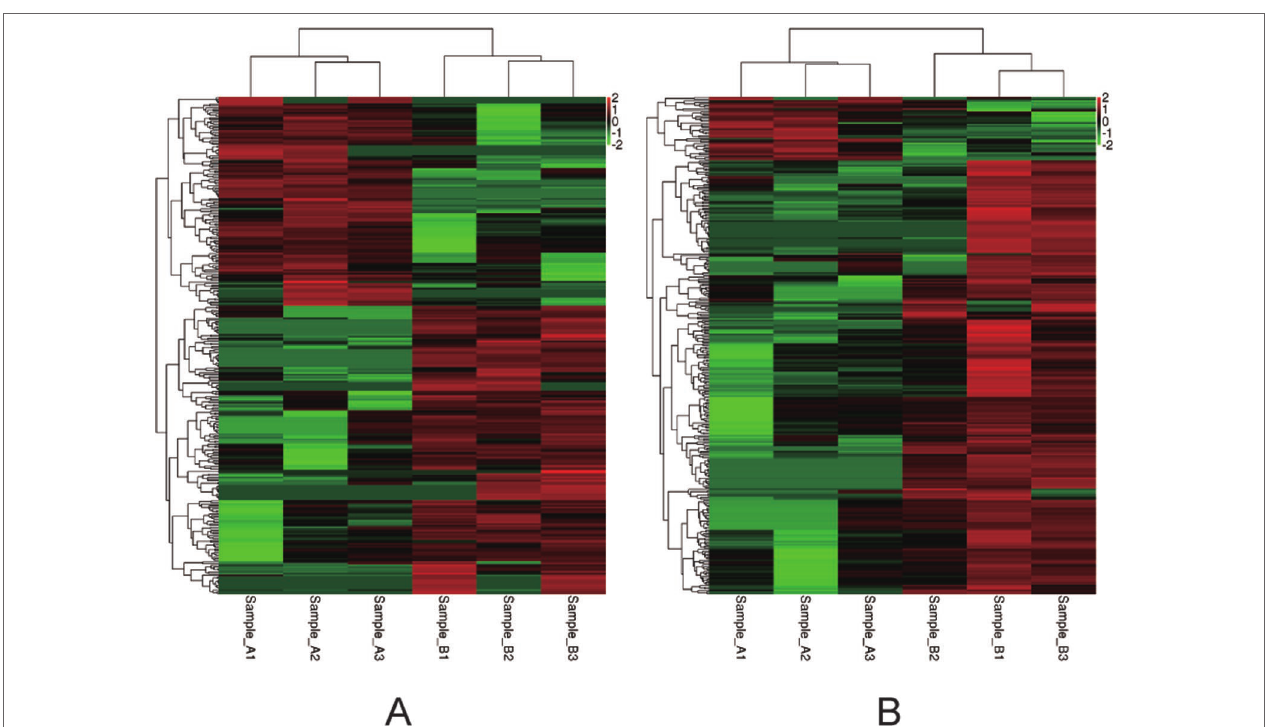
FIGURE 4 | Heat-maps (A and B) of hierarchical clustering analysis depicting the DEGs. The horizontal ordinate represents the clustering of samples from the air- control and hypoxia groups (F1, F2). The longitudinal coordinates represent the DEGs and the clustering of genes. The red color indicates upregulated genes, while the green color indicates downregulated genes. (A) the F1 generation: air-control versus hypoxia group. (B) The F2 generation: air-control versus hypoxia group.